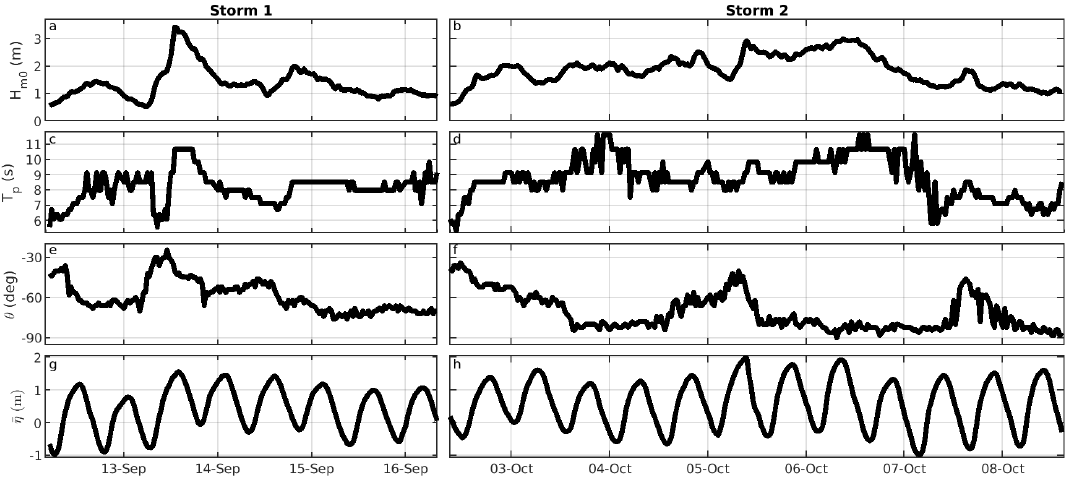
Figure 2. Overview of H m 0 ( a , b ), T p ( c , d ), θ ( e , f ), and the mean water level ¯ η ( g , h ) at F4 during storm 1 (left column) and storm 2 (right